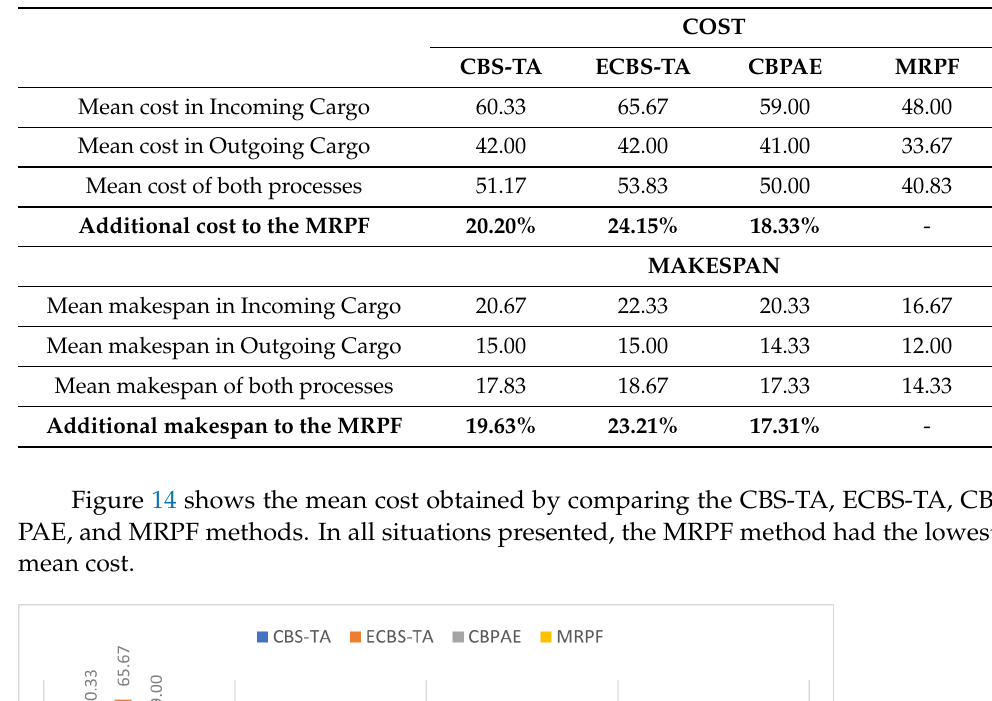
Table 11. Summary of comparison of the MRPF with similar methods.